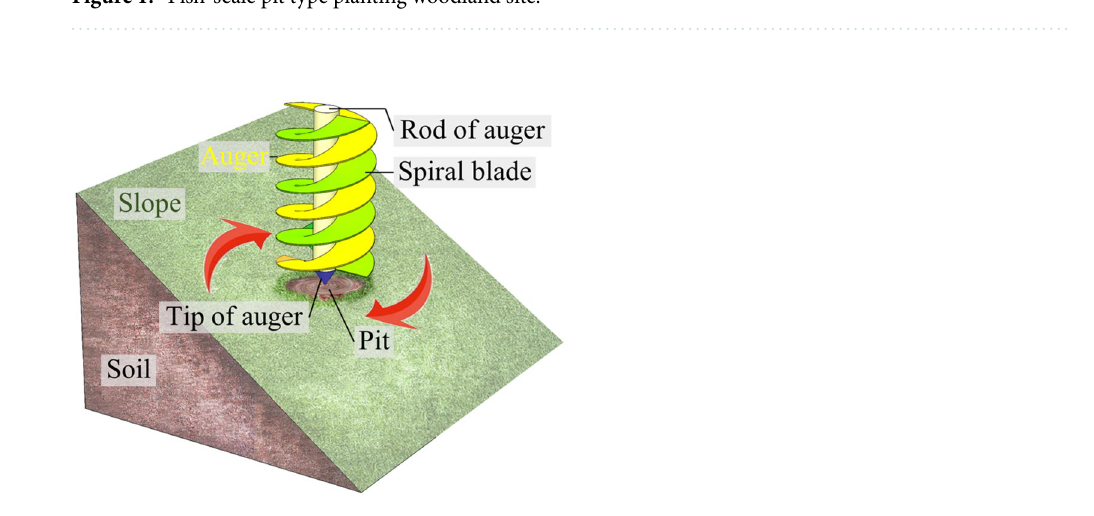
Figure 1. Fish-scale pit type planting woodland site.